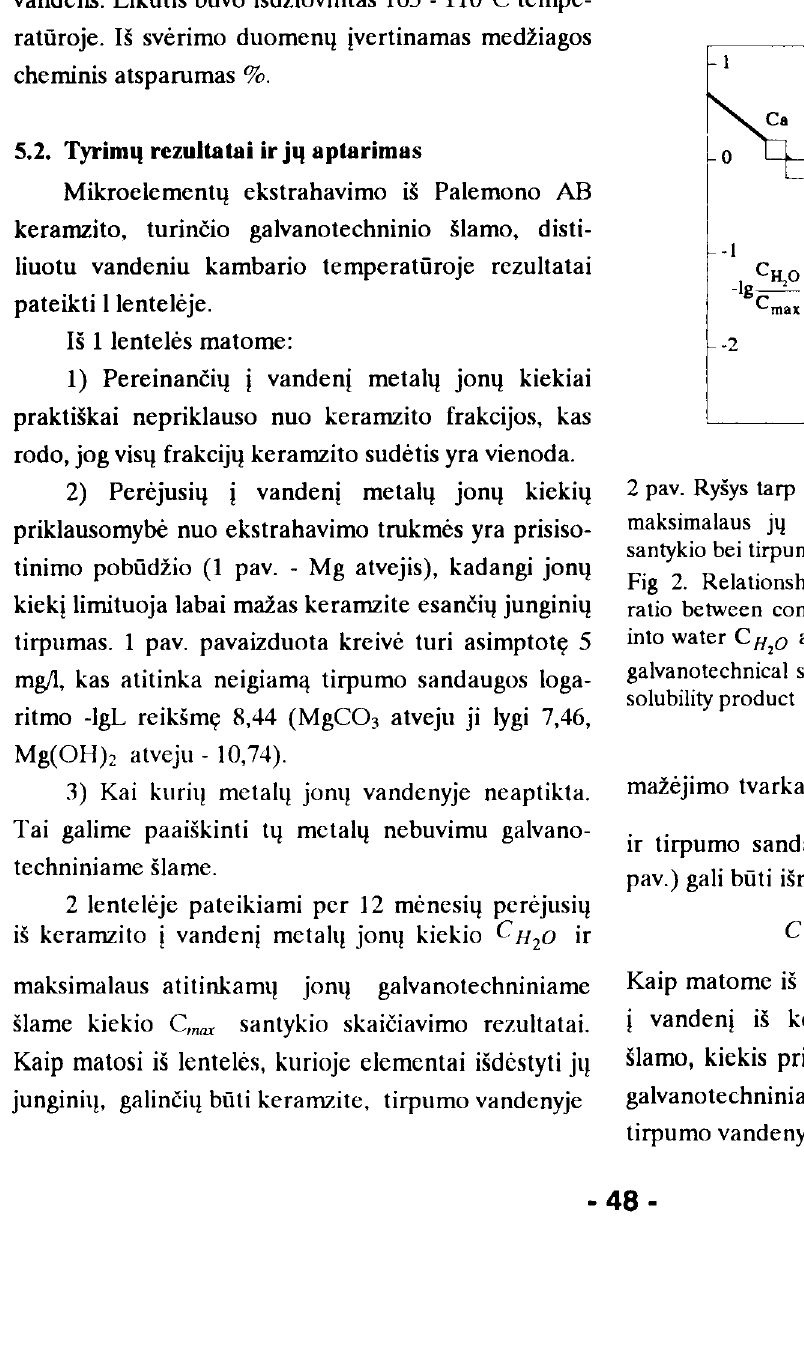
Fig 1. Dependence of the concentration of ions Mg 2 + transferred into water C H extraction T, months